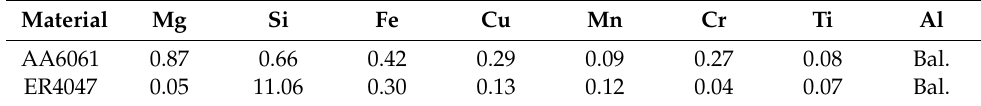
Figure 1. Schematic of ( a ) experimental setup, ( b ) the adjustment of average current, and ( c ) the collected signal of current and voltage. Table 1. Chemical compositions of base metal AA6061 and filler wire ER4047 (wt%).